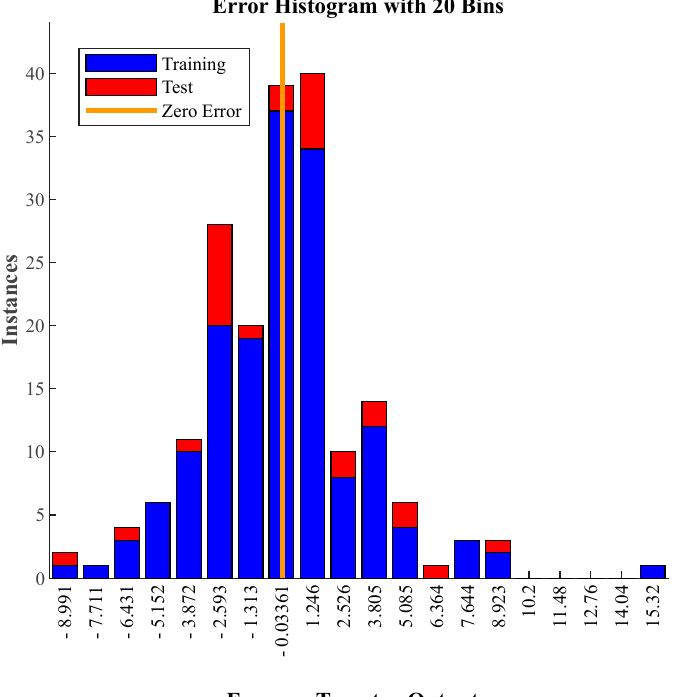
Figure 7. Error histogram of the optimal model.